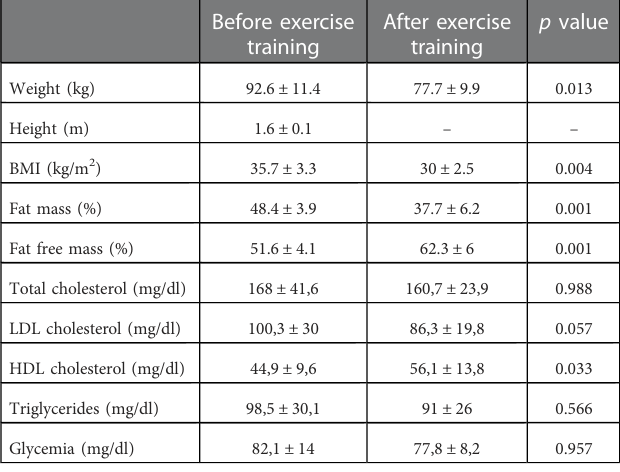
TABLE 1 Clinical characteristics of women who underwent bariatric surgery before and after a six months of exercise training protocol. Before exercise After exercise training training